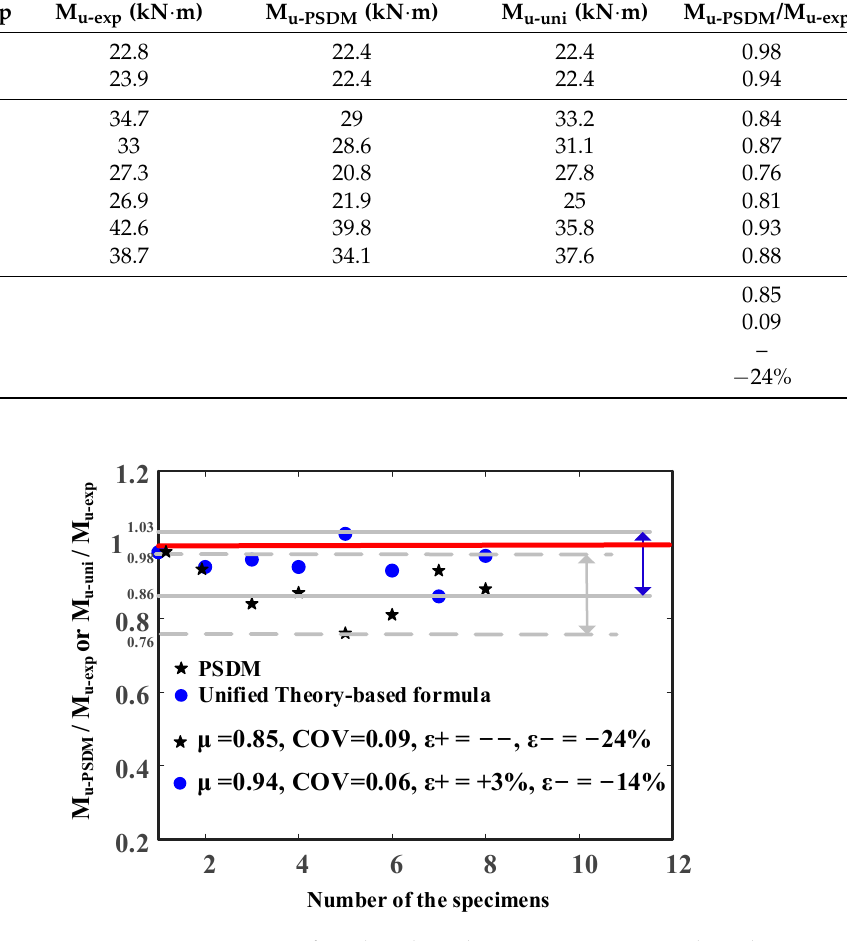
Figure 11. Comparison of predicted results against experimental